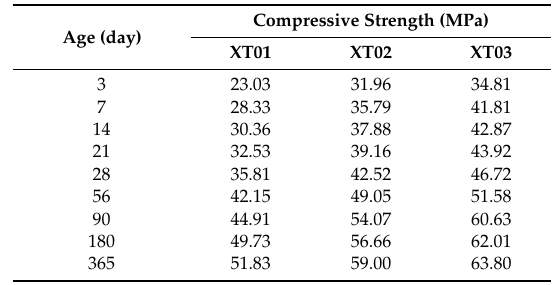
Table 5. Compressive strength of steel-slag concrete at various ages.